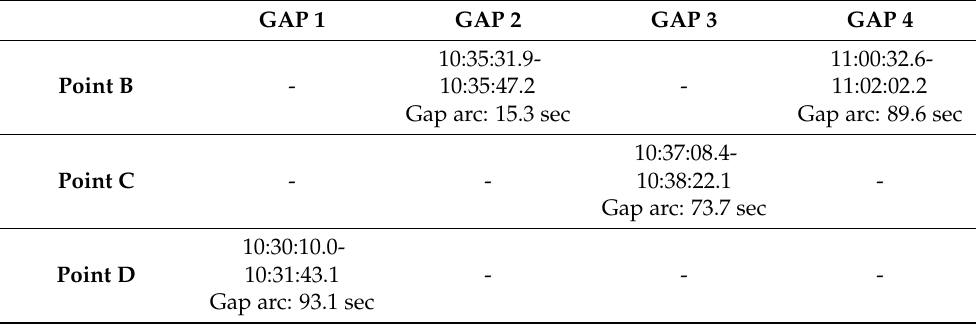
Table 2. GPS observation gaps at locations B, C and D over the 2 h from 10:00:00 to 12:00:00 on 11 March